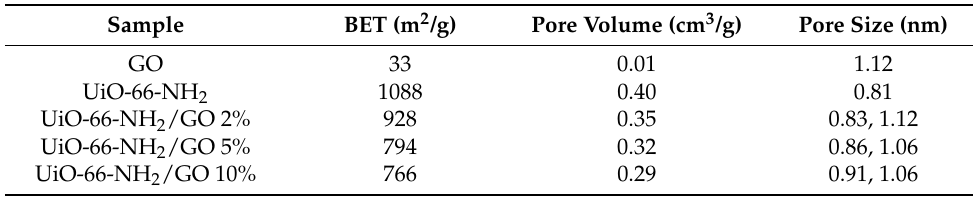
Table 3. Structure parameters of UiO-66-NH 2 /GO Y%.